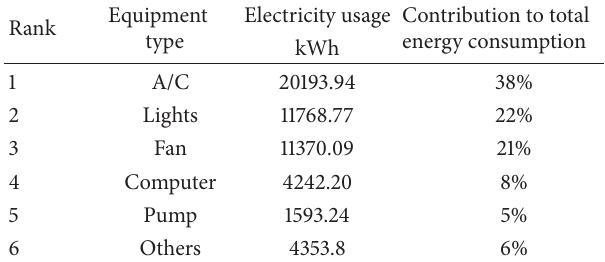
Table4:Numberofoperatinghoursfordifferentareasintheschool. Table 5: Top five energy consuming equipment types.